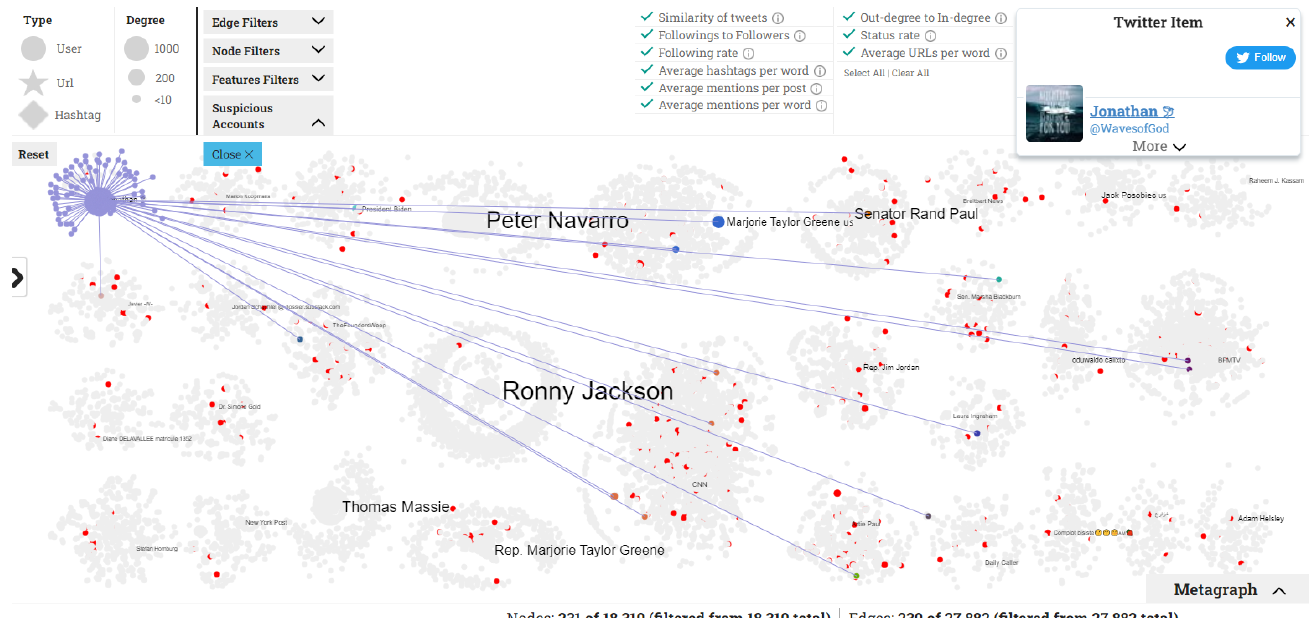
Figure 6. Example of a suspicious account in the Fauci analysis.